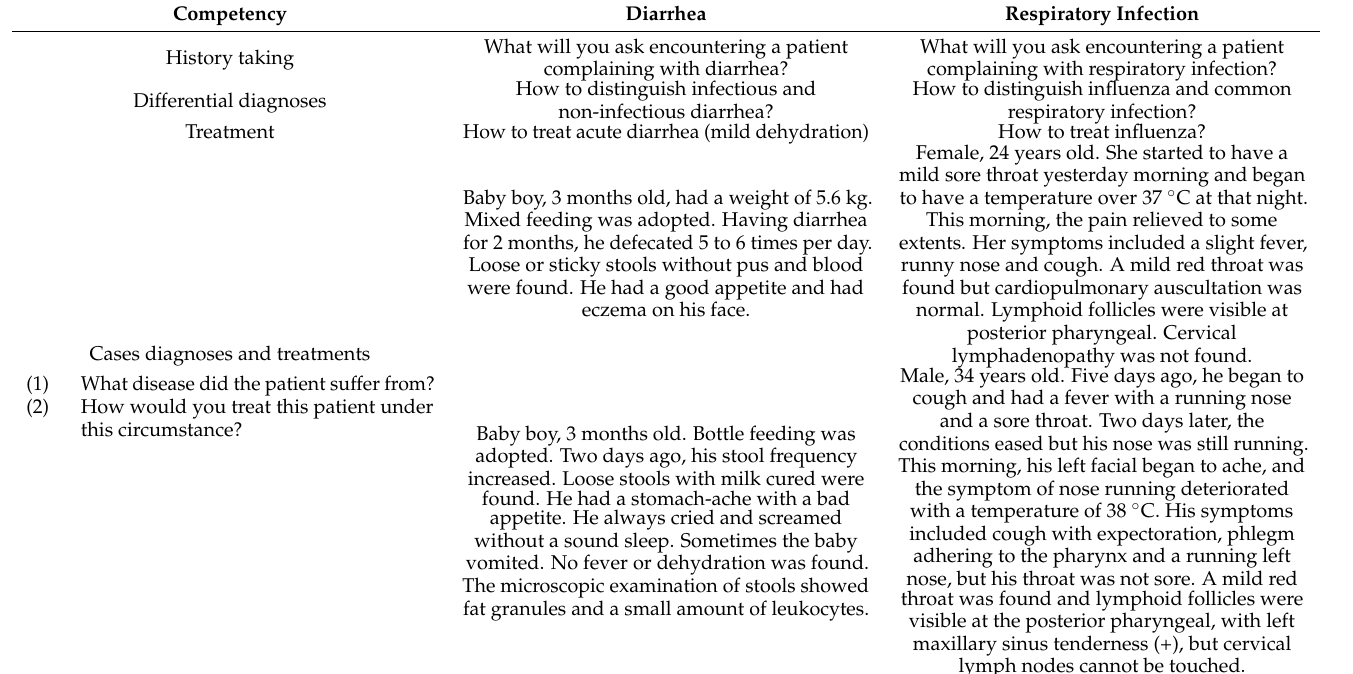
Table 1. Questions to measure technical